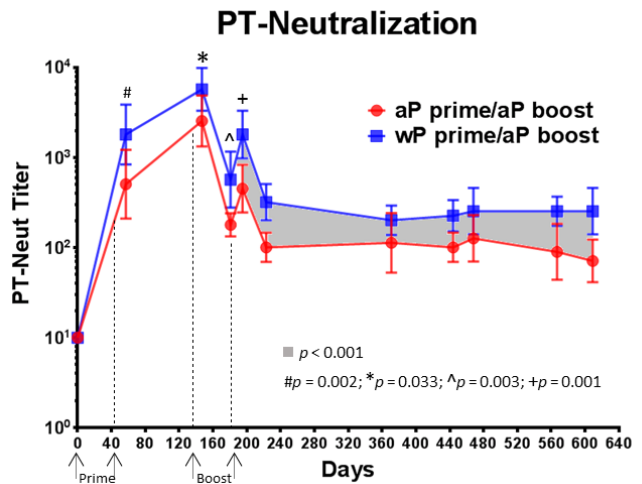
Figure 6. Priming with wP vaccine leads to elevated anti-PT neutralizing antibody titers. PT neutralization was assessed in the Chinese Hamster Ovary (CHO) cell cytotoxicity assay. The data shown at each time point are the mean values from 6 individual animals and the corresponding lines indicate the 95% CI. A statistical analysis was performed using two different models: (i) ANOVA model with the specific primary vaccine immunization (aP or wP) as the fixed factor for days 57, 147, 181, and 196. (ii) ANCOVA model with group as the fixed factor and time as the covariate for the interval between days 196 to 609. The p values are shown in the figure.